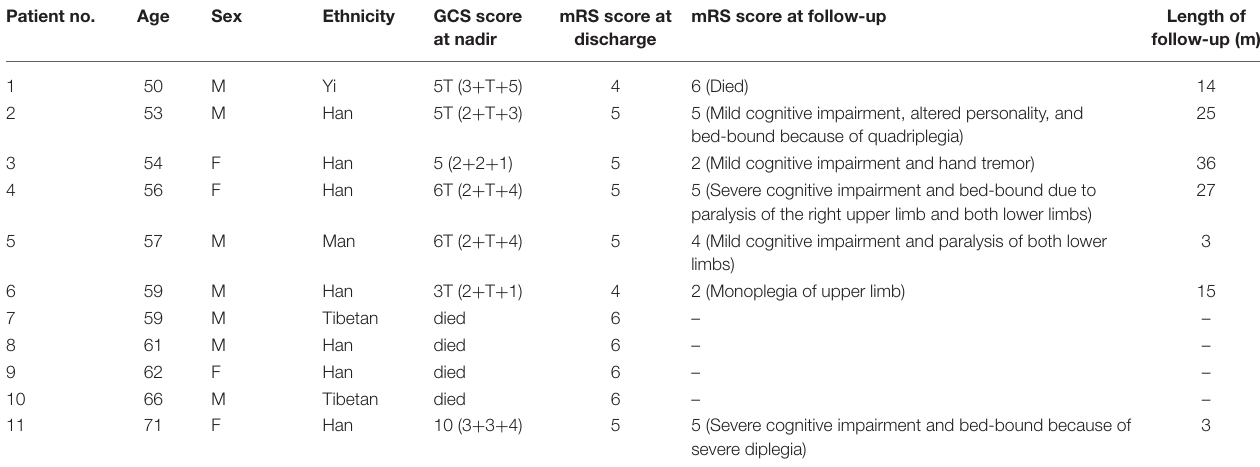
TABLE 2 | Severity of symptoms and outcomes of patients over 50 years old with Japanese encephalitis. Patient no. GCS score